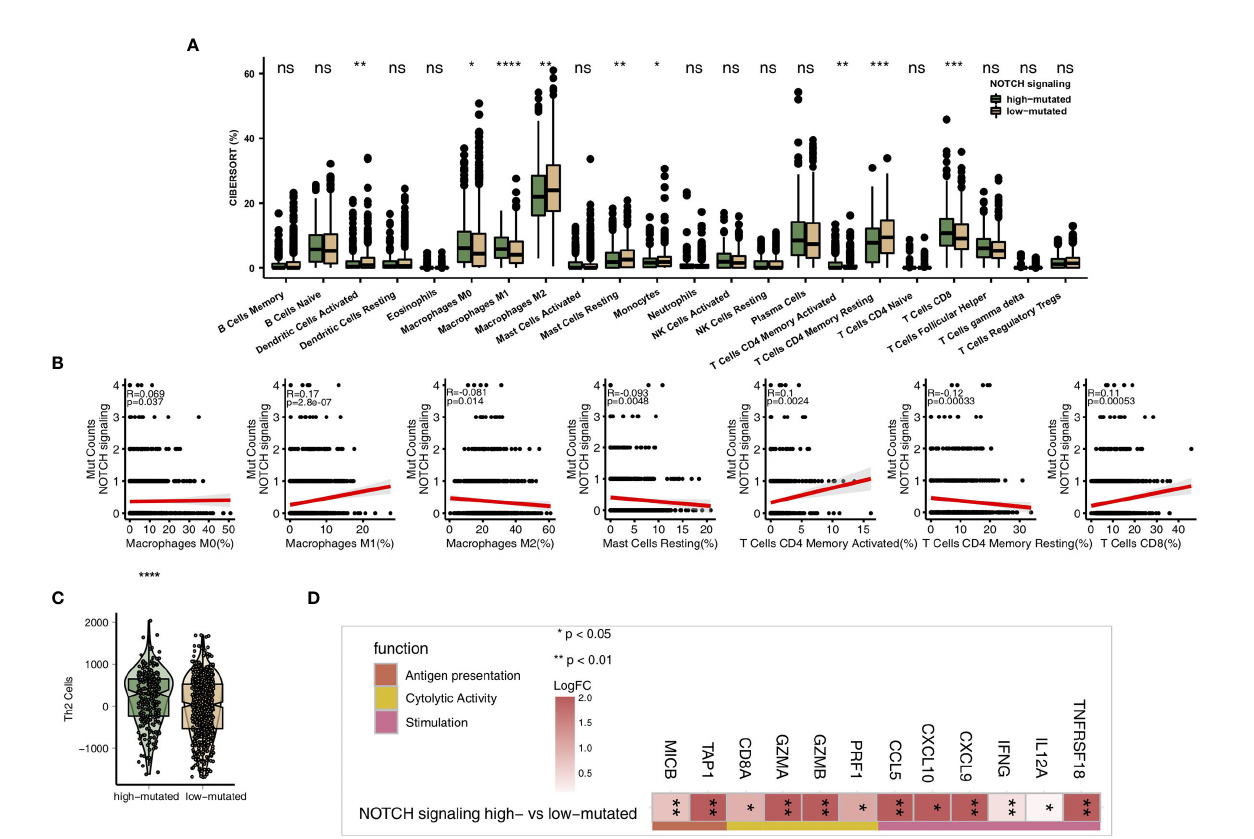
FIGURE 5 | (A) Comparison of the proportions of immune cells estimated by the CIBERSORT method between the high-mutated and low-mutated NOTCH groups in the TCGA-NSCLC cohort. (B) Correlations between the number of NOTCH signaling mutations and the proportions of each immune cell type. (C) Comparison of the Th2 signature between the high-mutated and low-mutated NOTCH groups in the TCGA-NSCLC cohort. (D) Comparison of the expression levels of immune- related genes between the high-mutated and low-mutated NOTCH groups in the TCGA-NSCLC cohort. (*P < 0.05; **P < 0.01; ***P < 0.001; ****P < 0.0001; Mann- Whitney U test). NS, not signi fi